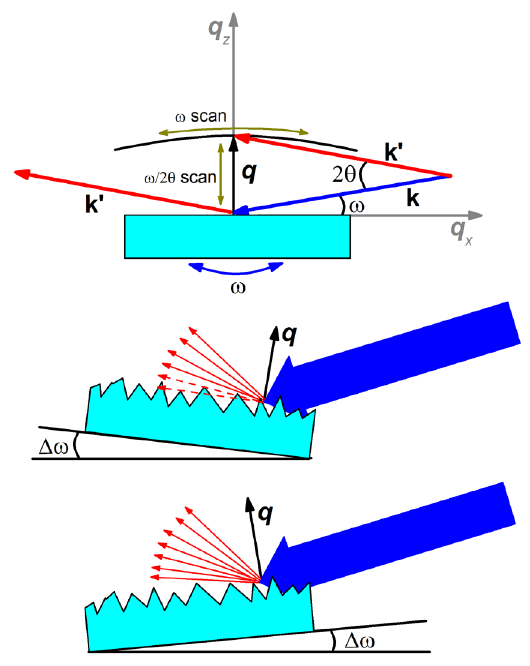
Figure 4. Schematic diagram of RSM measuring and formation scheme of diffuse scattering at different incidence angles of X-rays.